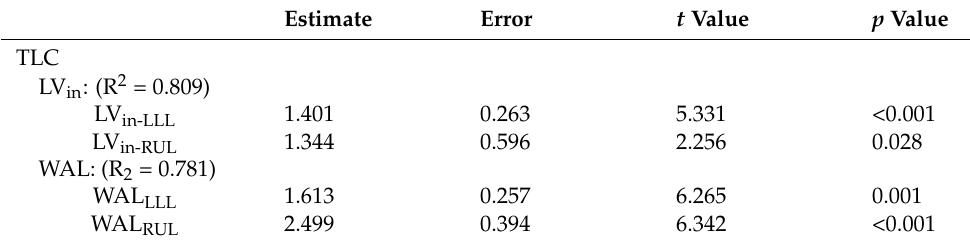
Table 3. Multiple linear regression analysis for ventilatory